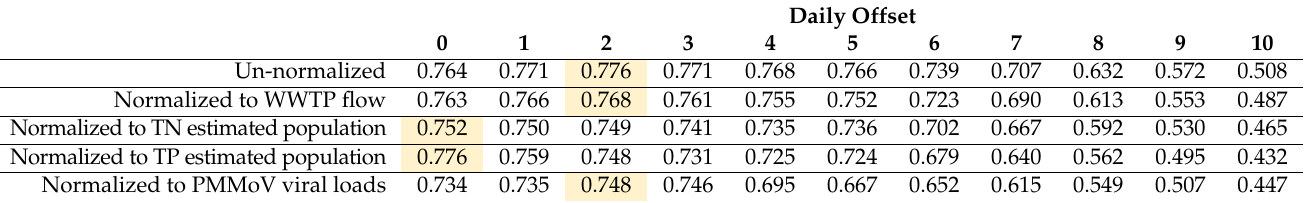
Table 1. Time-shifted analyses of the Pearson correlation coefficients (r) at UDD WWTP between un-normalized as well as normalized SARS-CoV-2, and the 7-day rolling averages of clinical cases offset over a time period of 1–10 days (where 0 refers to the wastewater sample collection date). Daily